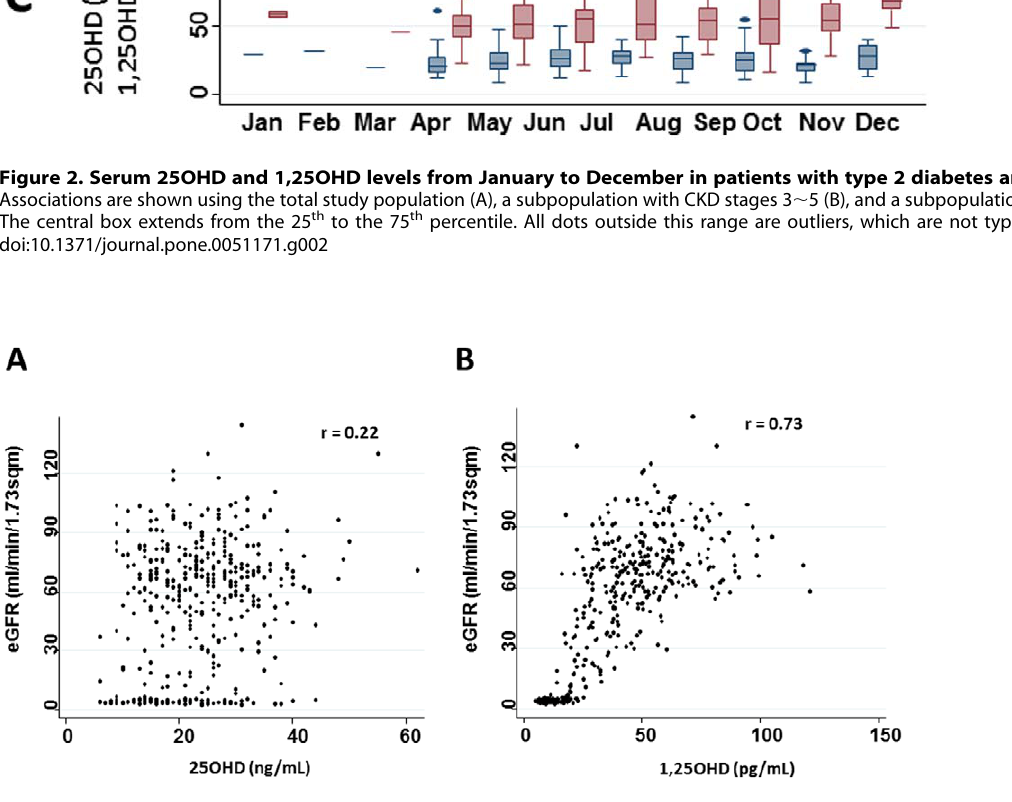
PLOS ONE | www.plosone.org